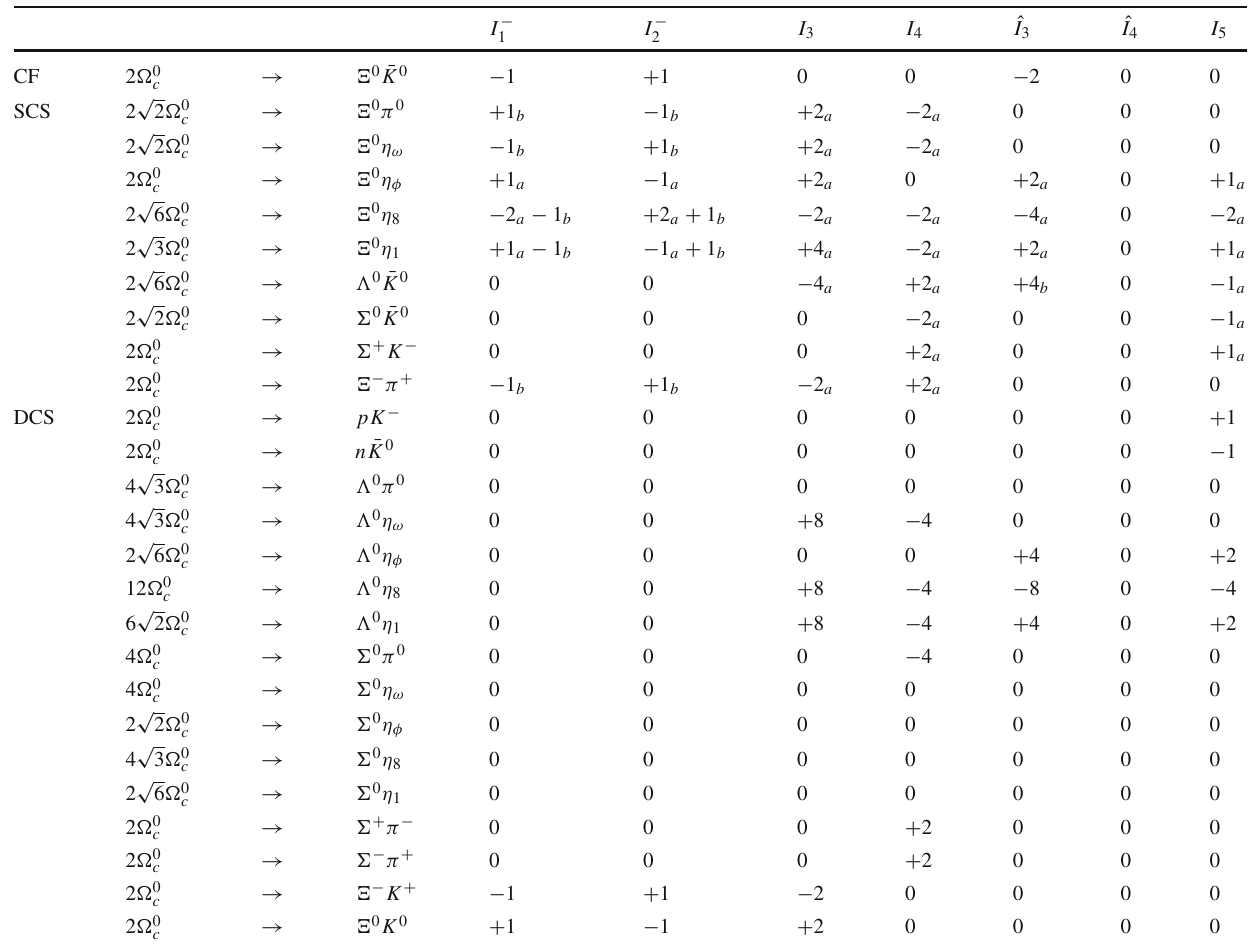
Table 8 Values of the seven topological tensor invariants for the non- leptonic CF, SCS and DCS decays of the sextet charm baryon state (cid:10) 0 c belonging to the class of decays B c ( 6 ) → B ( 8 ) + M ( 8 , 1 ) . The SCS decays are induced by the flavor transition ( a ) ( c → s ; s → u ) and